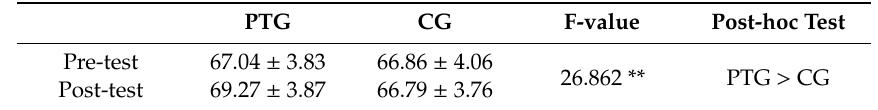
Table 5. Values are the mean ± standard deviation. Data are reported for the maximum vertical jump height. Units in centimeters